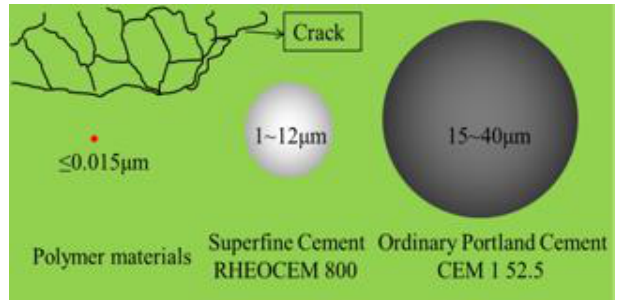
Figure 17. Comparison of the particle size and infiltration capacity of different materials.